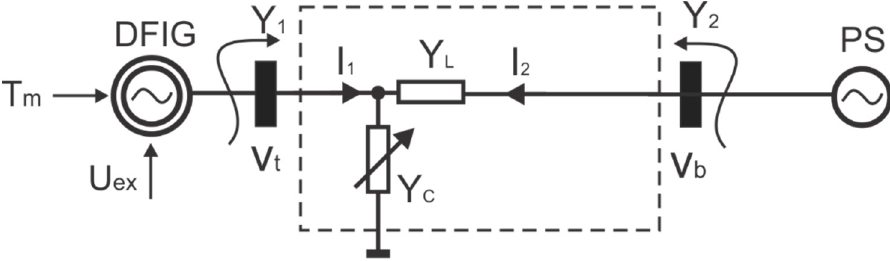
Figure 1. Induction generator with a local consumer connected to a power grid.